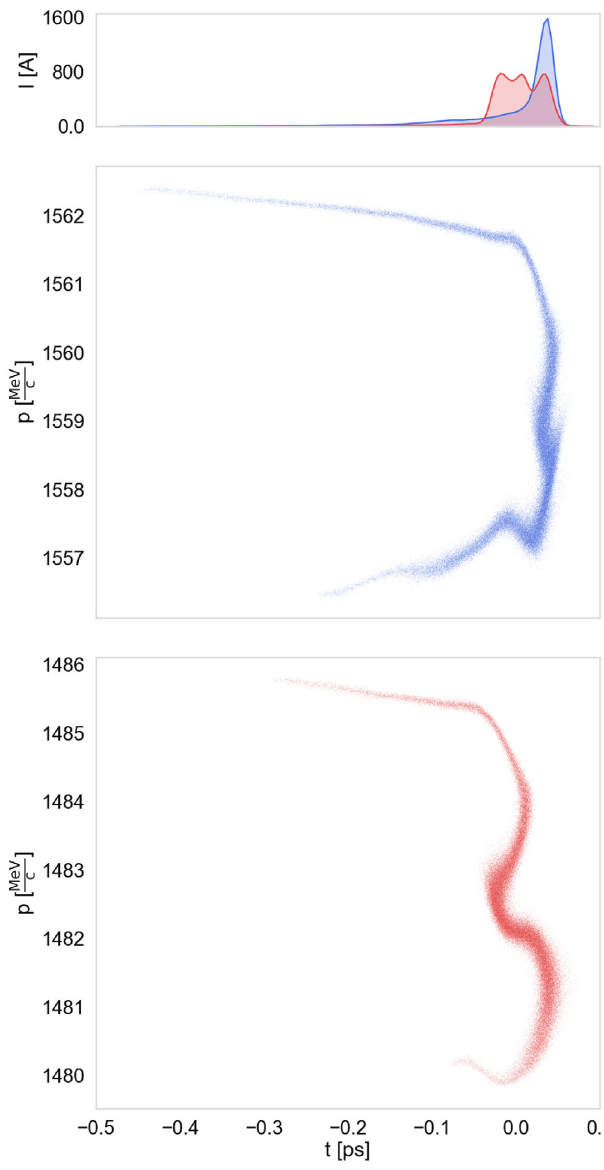
FIG. 10. LPS at the BAC exit. In blue the case where the CSR effect is precompensated by the acceleration in HHL, in red a test case with the HHL turned off. On top of the image a plot showing the relative current profiles.